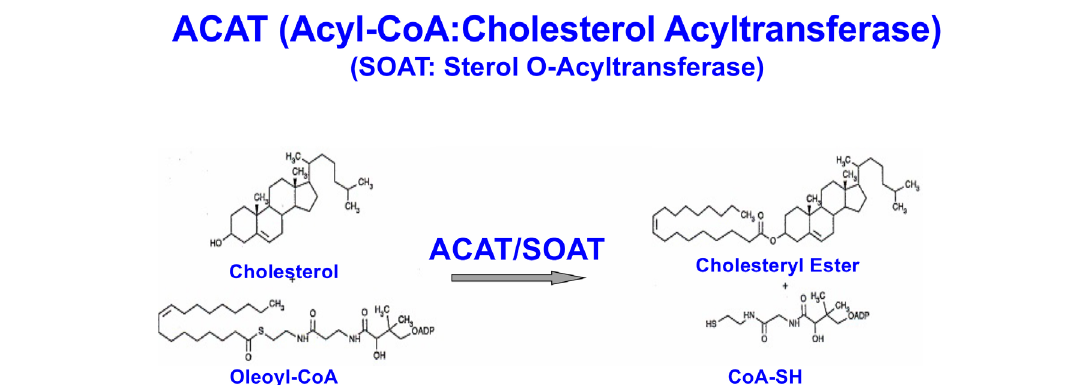
Figure 2. Biochemical reaction catalyzed by the enzyme ACAT/SOAT ACAT1 blockade and